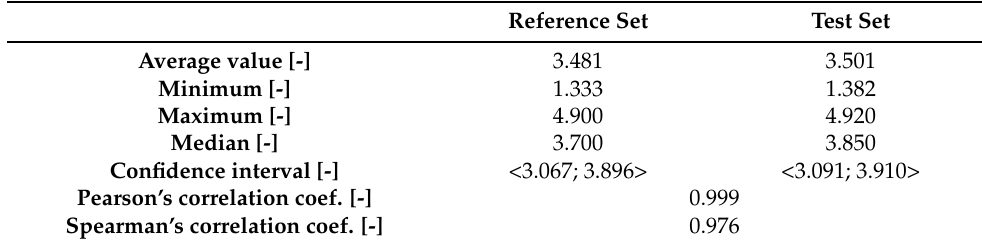
Table 10. Descriptive statistics for MOS prediction, Ultra HD, H.264 + H.265.